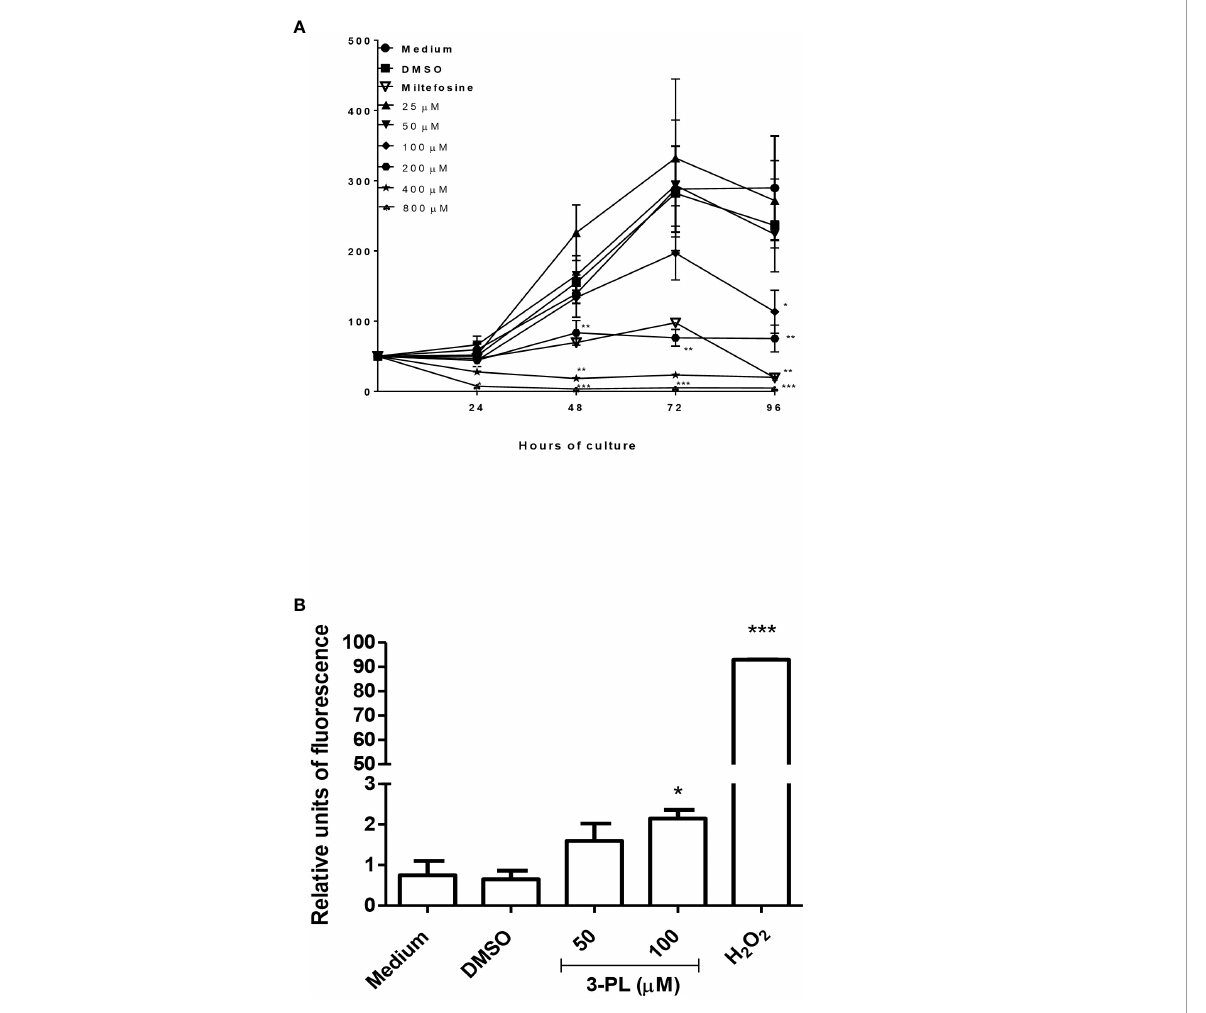
FIGURE 3 Evaluation of the direct toxic effect of 3-PL on the parasite. Promastigotes were cultured in the presence of indicated concentrations of 3-PL or 6µM miltefosine for 96h at 28°C. (A) Promastigote growth was assessed by daily counting in a Neubauer chamber. (B) Promastigote ROS generation detected by H2DCFDA probe after treatment with 100 µM 3-PL for 72h. Hydrogen peroxide (H 2 0 2 ) was used as a positive control for ROS detection. Results were presented as means ± SD, n=3. *p < 0.05, **p < 0.01 and ***p < 0.001 in relation to control